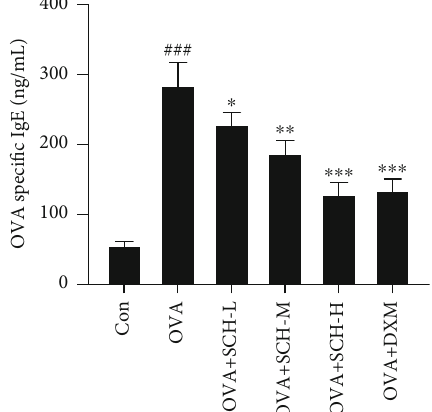
Figure 4: E ff ect of SCH on the level of OVA-speci fi c IgE. BAL fl uids were collected to detect OVA-speci fi c IgE. Data are presented as the means ± SD ; n = 6 . ### p < 0 : 001 compared with the control group; ∗∗∗ p < 0 : 001 , ∗∗ p < 0 : 01 , and ∗ p < 0 : 05 compared with the OVA